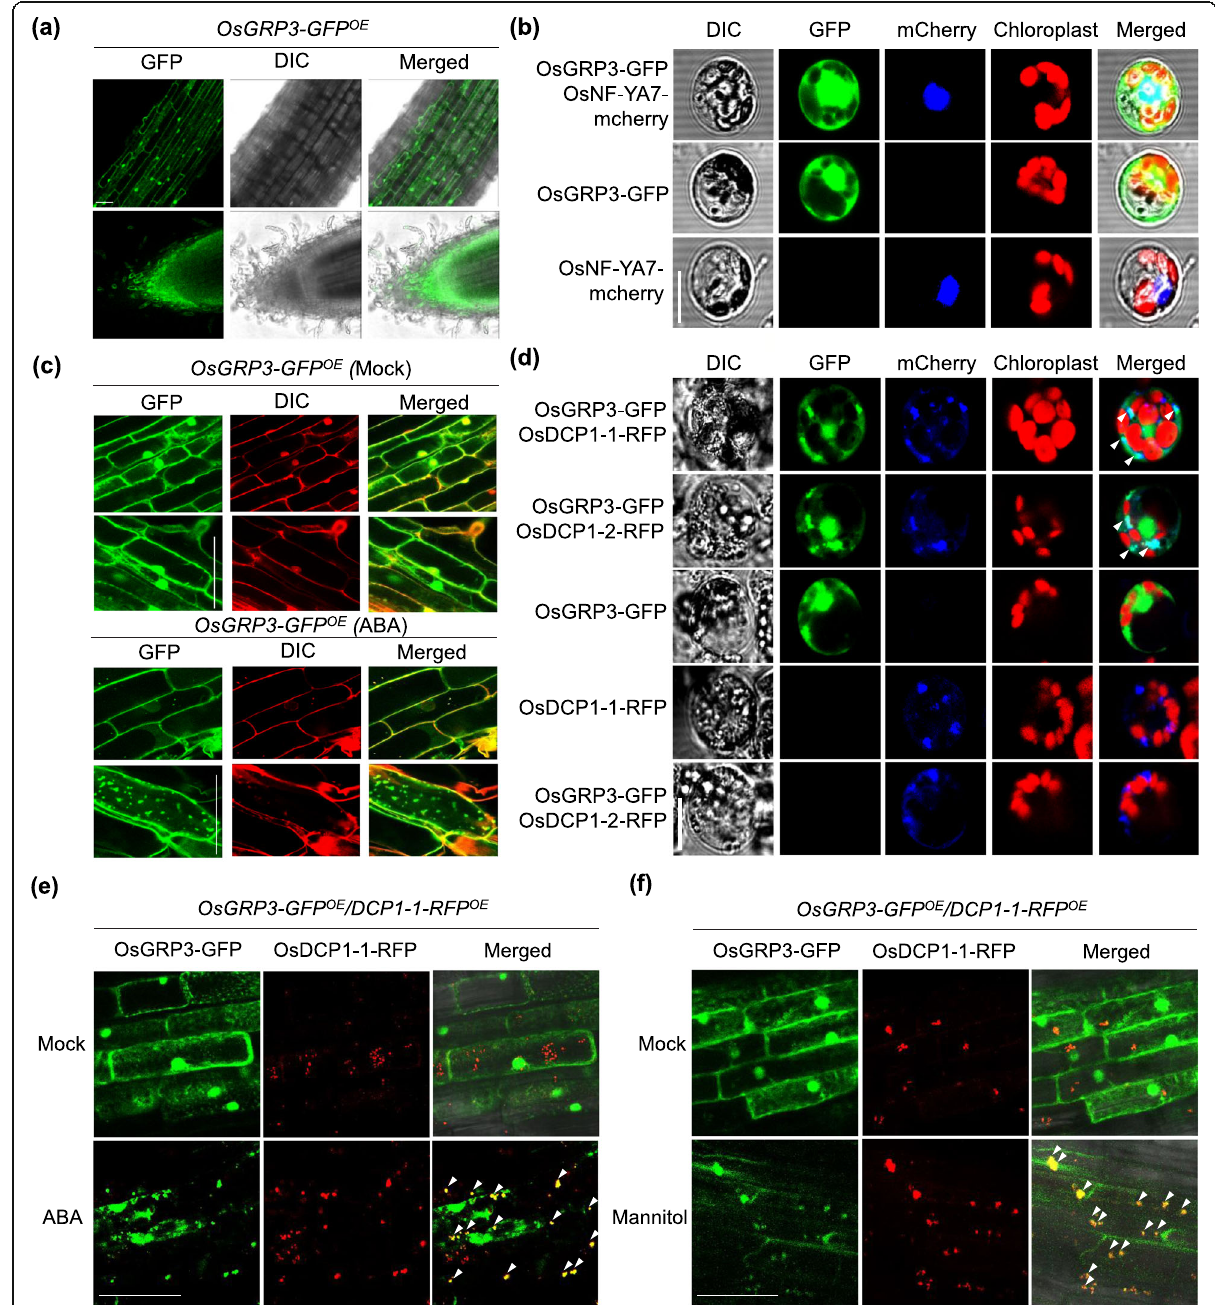
Fig. 3 Change of subcellular localization of OsGRP3 in response to abiotic stresses. a Subcellular localization of OsGRP3 was visualized by detecting GFP fluorescence in roots of OsCc1::OsGRP3-GFP ( OsGRP3-GFP OE ) transgenic plants under normal growth conditions. Bar = 30 μ m. b OsGRP3-GFP and OsNF-YA7-mCherry were transformed into rice protoplasts. Fluorescence of GFP, mCherry, and chloroplast was analyzed using confocal microscopy. Bar = 10 μ m. c GFP Fluorescence in roots of OsGRP3-GFP OE transgenic plants was analyzed 6 h after treatment with ABA. Propidium iodide (PI) staining was used for visualizing outlines of root cells. Bar = 30 μ m d Fluorescence of GFP, RFP and chloroplast were analyzed in the transformed protoplasts 6 h after ABA treatment using confocal microscopy. Bar = 10 μ m. GFP Fluorescence in roots of OsGRP3- GFP OE / DCP1 – 1-RFP OE transgenic plants was analyzed 6 h after treatment with ABA ( e ) and Mannitol ( f ). Bar = 30 μ m. White arrows indicate co- localized sites of OsGRP3 and